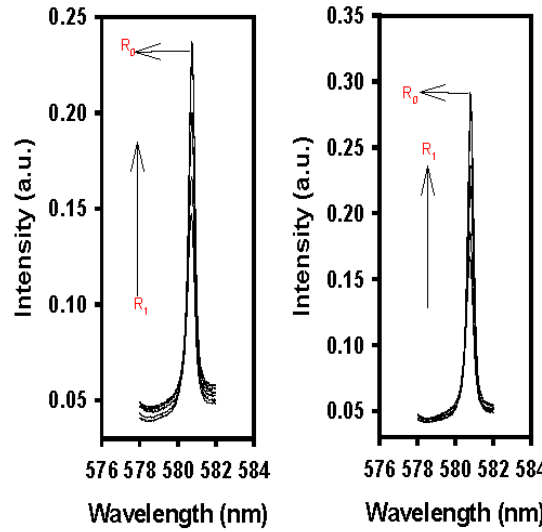
Figure 4. R 1 : 5 D 0 ← 7 F 0 (Eu) excitation spectra for solutions containing 0.005 M [Eu(DPA) 3 ] 3 − , 40 equiv. L -serine with solvent ratios of H 2 O:NMF (left) and H 2 O:DMF (right) from 90:10 to 50:50. R 0 : 5 D 0 ← 7 F 0 (Eu) excitation spectra for the control containing 0.005 M [Eu(DPA) 3 ] 3 − , 0 equiv. L -serine, and 50:50 H 2 O:NMF ( left ) and H 2 O:DMF ( right ), respectively.